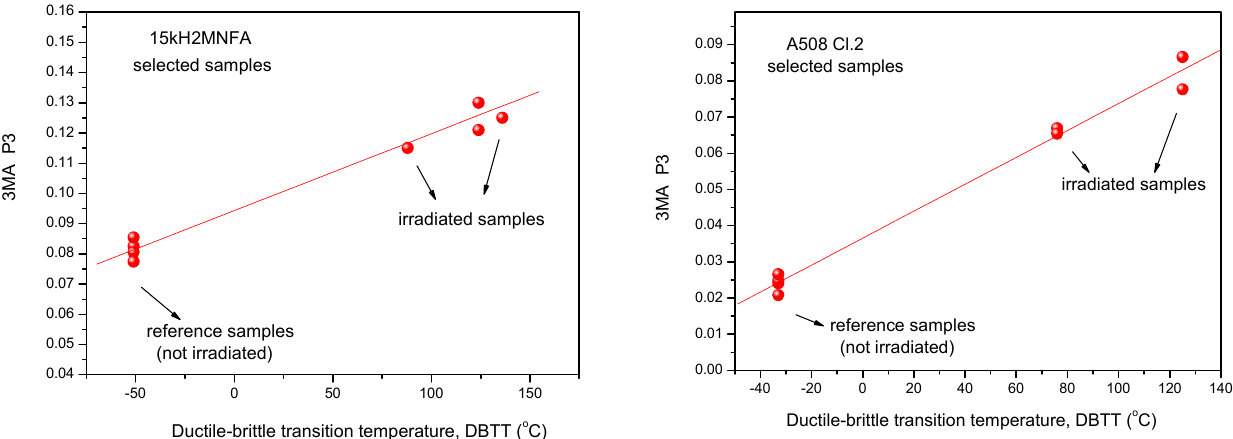
Figure 11. Optimally chosen MAT descriptor vs. transition temperature for selected 15kH2NMFA and A508 Cl.2 samples.